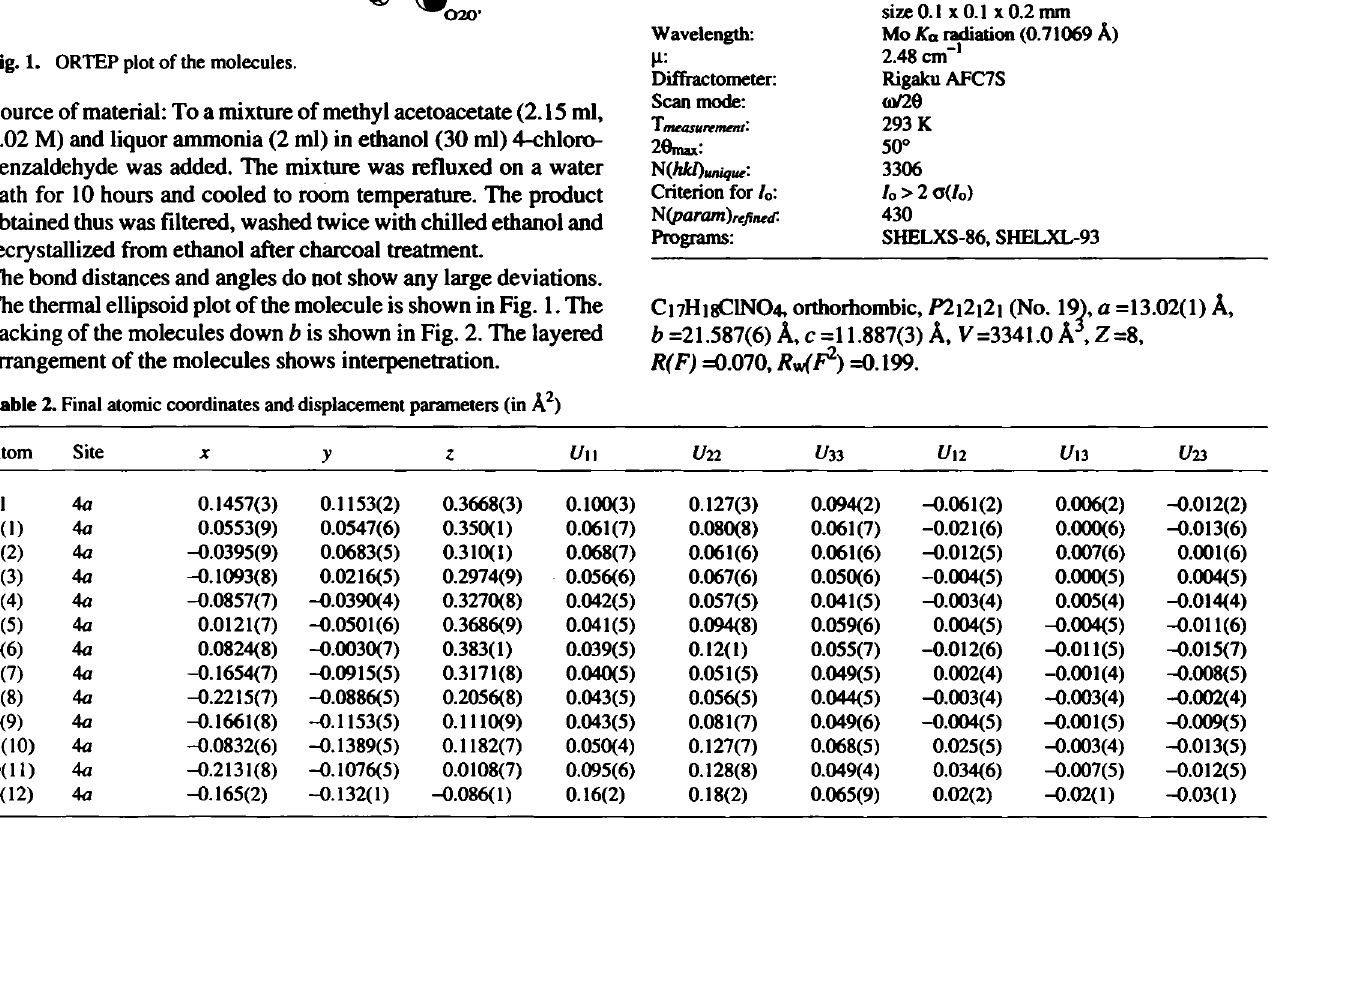
Fig. 2. Packing of molecules down b. Table 1. Parameters used for the X-ray data